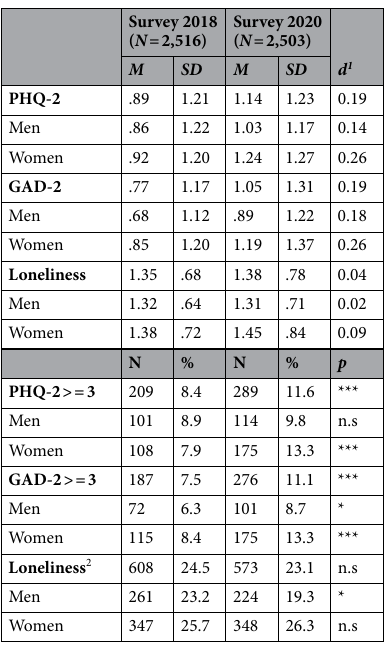
Table 1. Comparisons of depression and anxiety symptoms, and loneliness between 2018 and 2020 for all participants, women, and men. Norm scores: PHQ-2: 0.94 (1.20), GAD-2: 0.82 (1.10) 16 ; 1 Cohen’s d; 2 at least some degree; Chi 2 : * p < 0.05, ** p < 0.01, *** p <